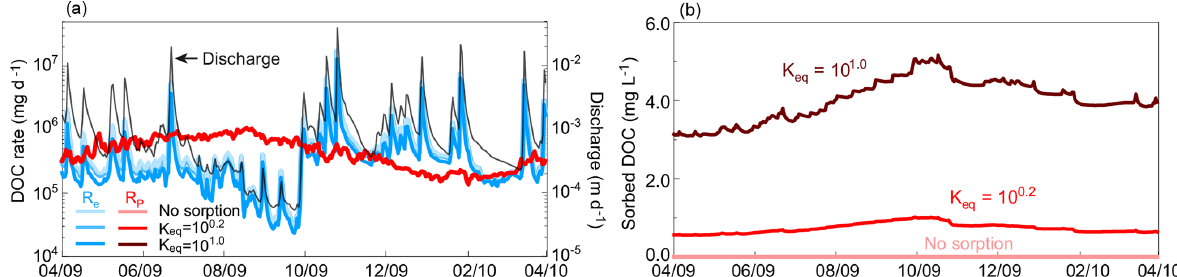
Figure 10. Sensitivity analysis of the sorption equilibrium constant K eq on (a) R p and R e and on (b) DOC sorbed on soils averaged at the catchment scale. High K eq led to more DOC sorbed on soils and, therefore, lower R e . However, R e showed similar temporal patterns regardless of K eq